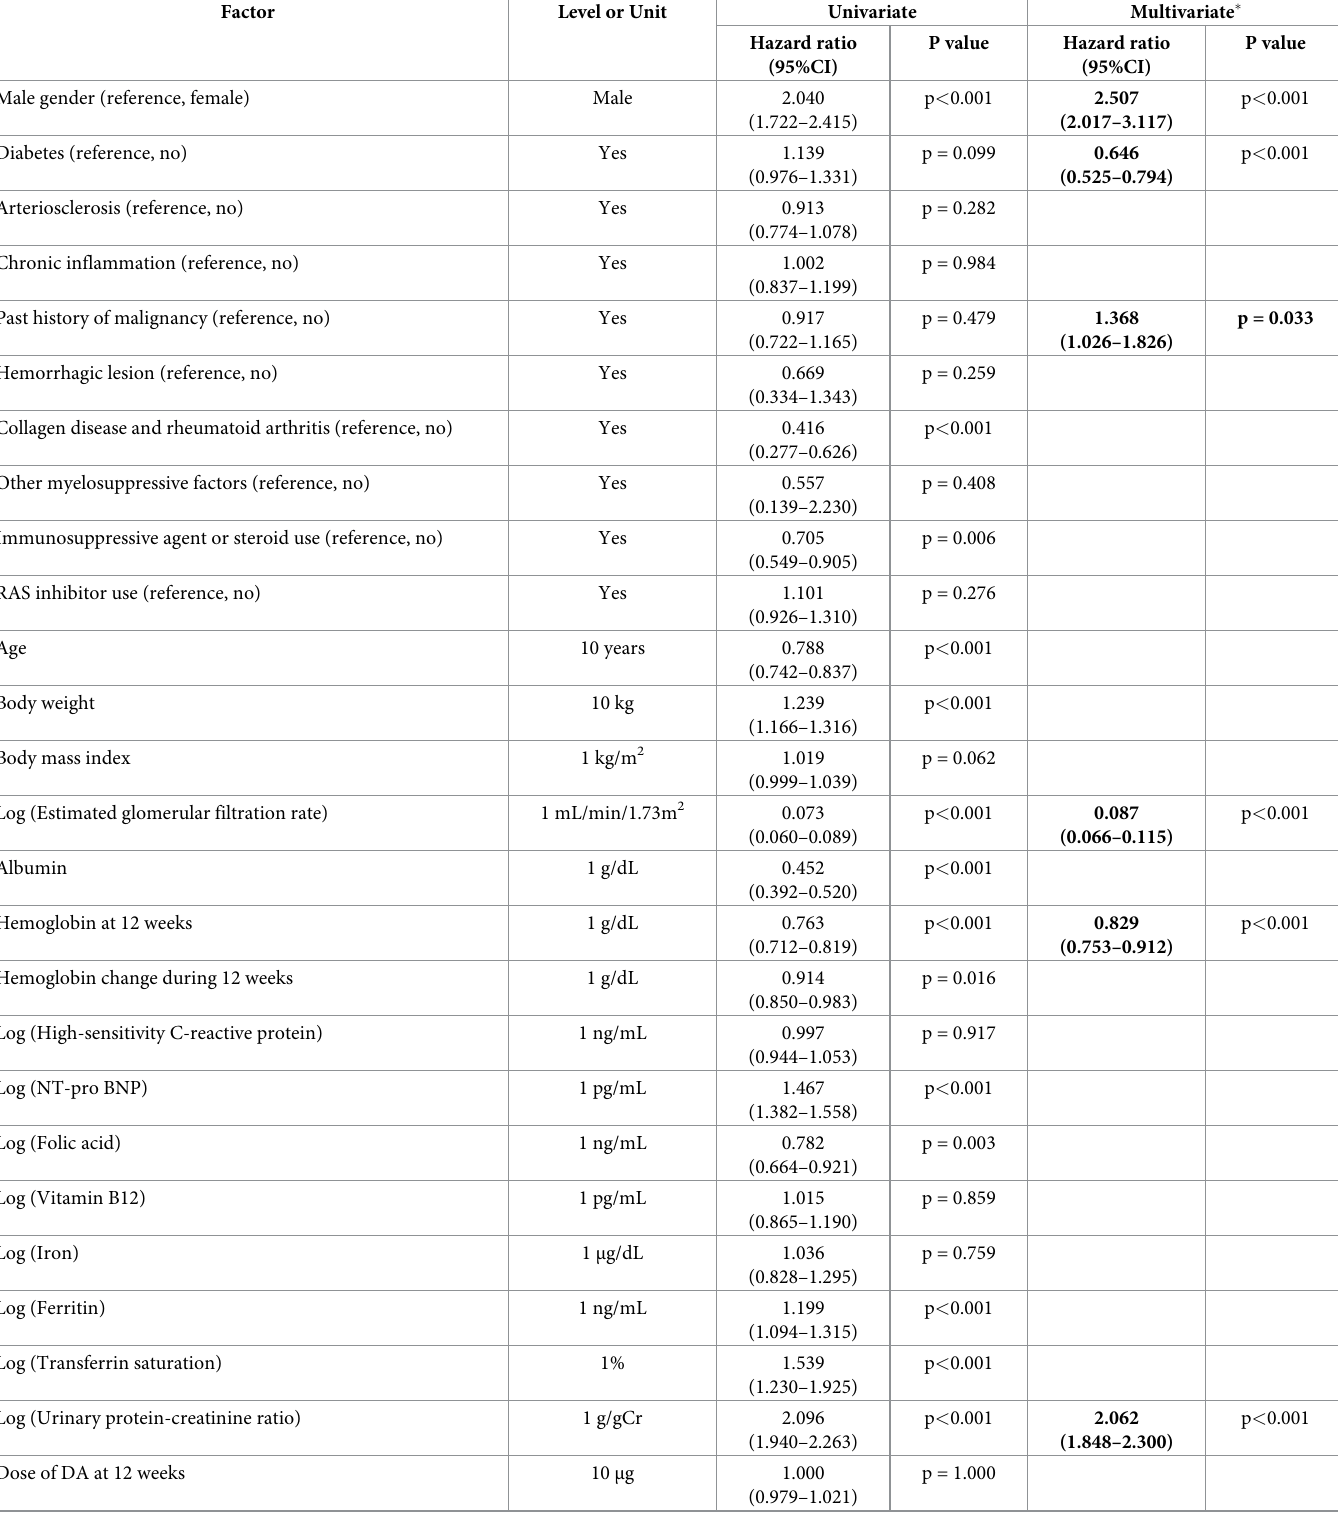
Table 2. Cox proportional hazards model analysis for deterioration of renal